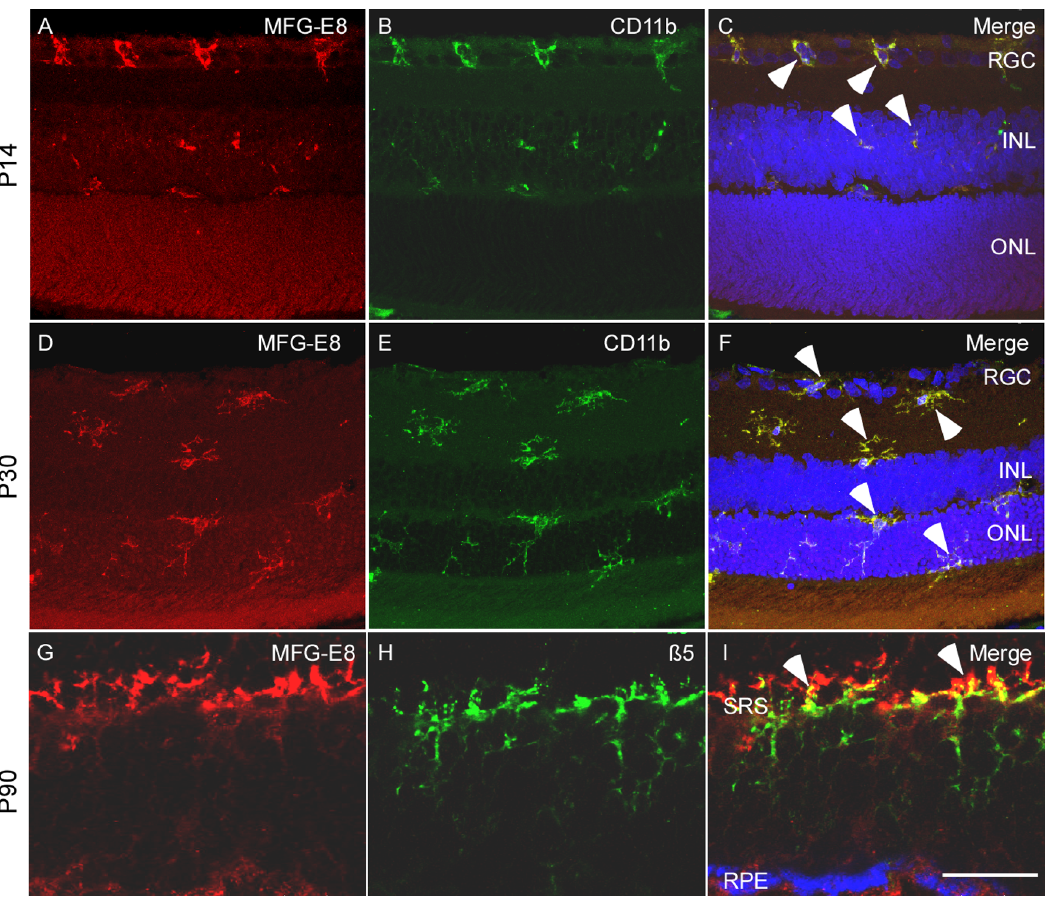
Figure 1. Microglial cell feature with two types of shape was identified in the MFG-E8 positive cells in the retina of the RCS rats. Double labelling was applied to detect the cell expressions MFG-E8 and CD11b. At P14 (A–C), most MFG-E8 labelled cells were found in the ganglion cell layer (GCL), with amoeboid shape (indicated by arrow heads). At P30 (D–F), MFG-E8 and CD11b positive cells show a well-ramified shape distributed in the whole retina (indicated by arrow heads). Double immunofluorescent staining indicates the expression of MFG-E8 (G) and ß5 integrin (H) in the retina of RCS rats at P90. (I) ß5 is mainly distributed in the subretinal space (SRS) and closely binds with MFG-E8 (indicated by arrow heads). Scale bar: 20 m